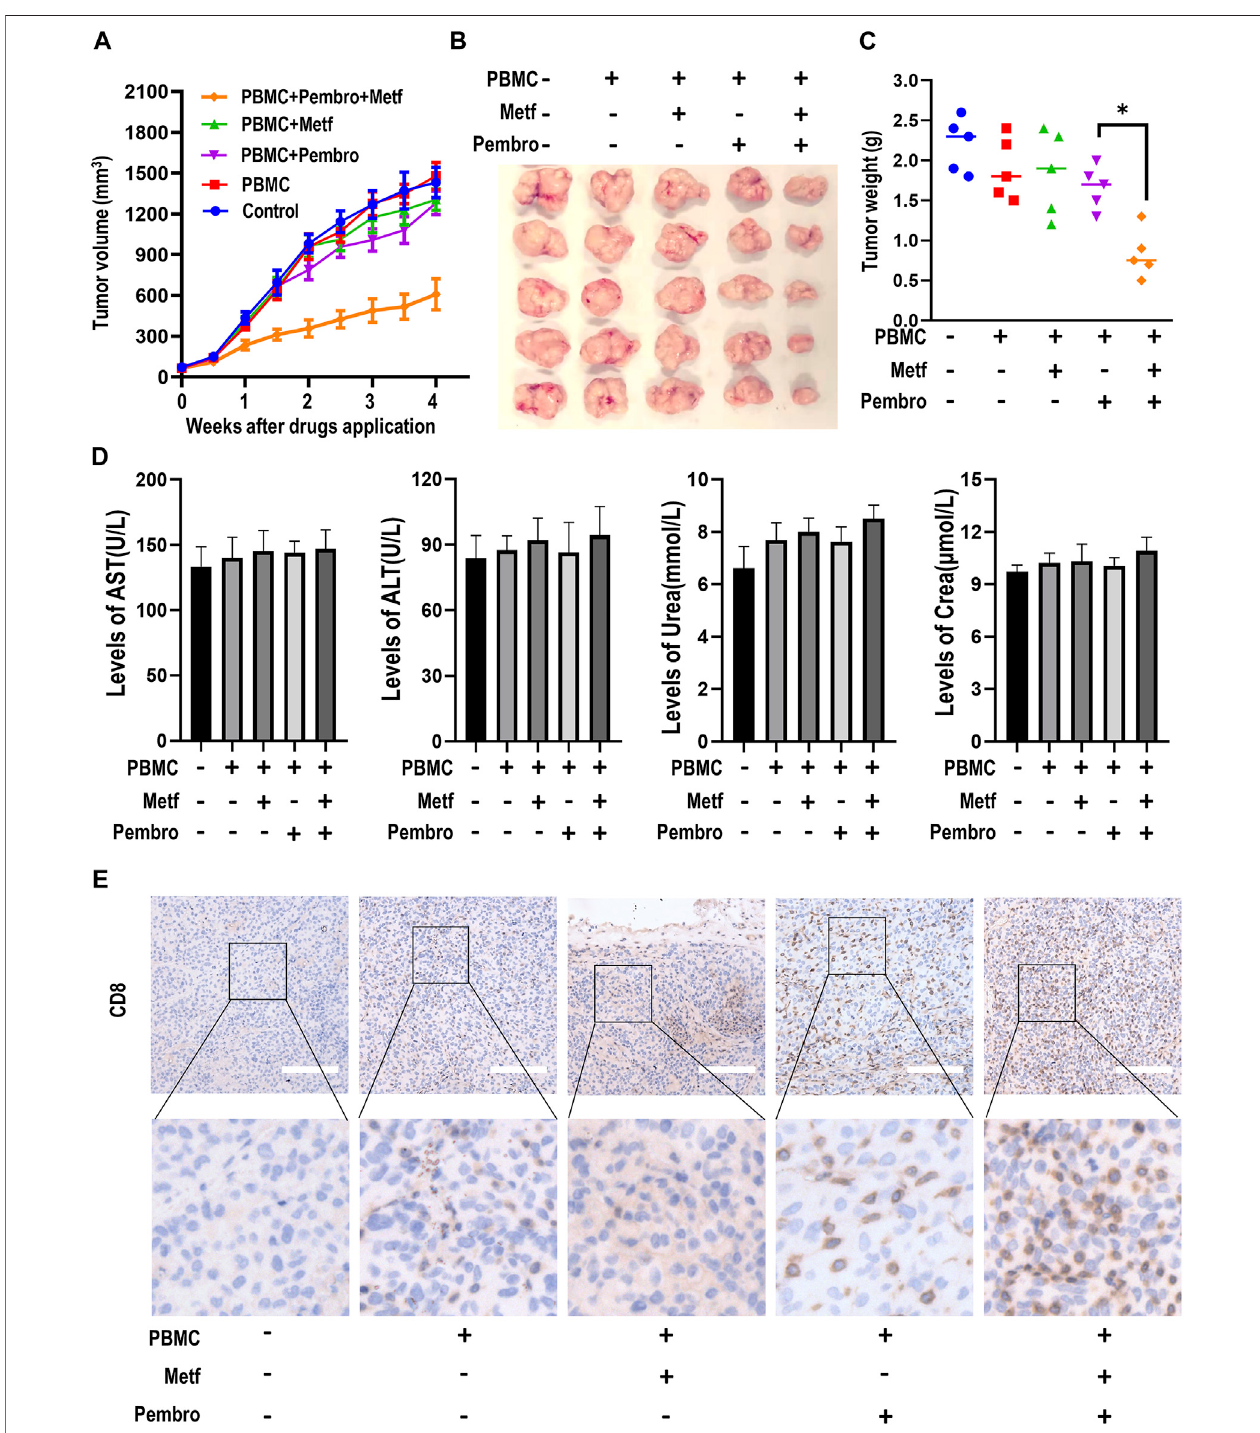
FIGURE 2 | Metformin enhanced the ef fi cacy of PD-1 inhibitor in PBMCs-CDX mouse model. (A) , Tumor growth curve of H460-derived xenograft mouse models treated as indicated. Tumor volume was shown as mean ± SEM ( n = 5). *, p < 0.01 compared with the pembrolizumab group. (B) , Macroscopic appearance of tumors after drug application for 4 weeks (C) , Tumor weight (g) of each mouse was shown. *, p < 0.01. (D) , The levels of serum AST, ALT, Urea and Creatinine in mice serum were presented as mean ± SEM ( n = 5). (E) , Immunohistochemistry analysis of CD8 in tumor sections from different groups. Representative images were shown. Scale bars: 200 μ m. AST, Aspartate aminotransferase; ALT, Alanine aminotransferase; Crea, Creatinine.